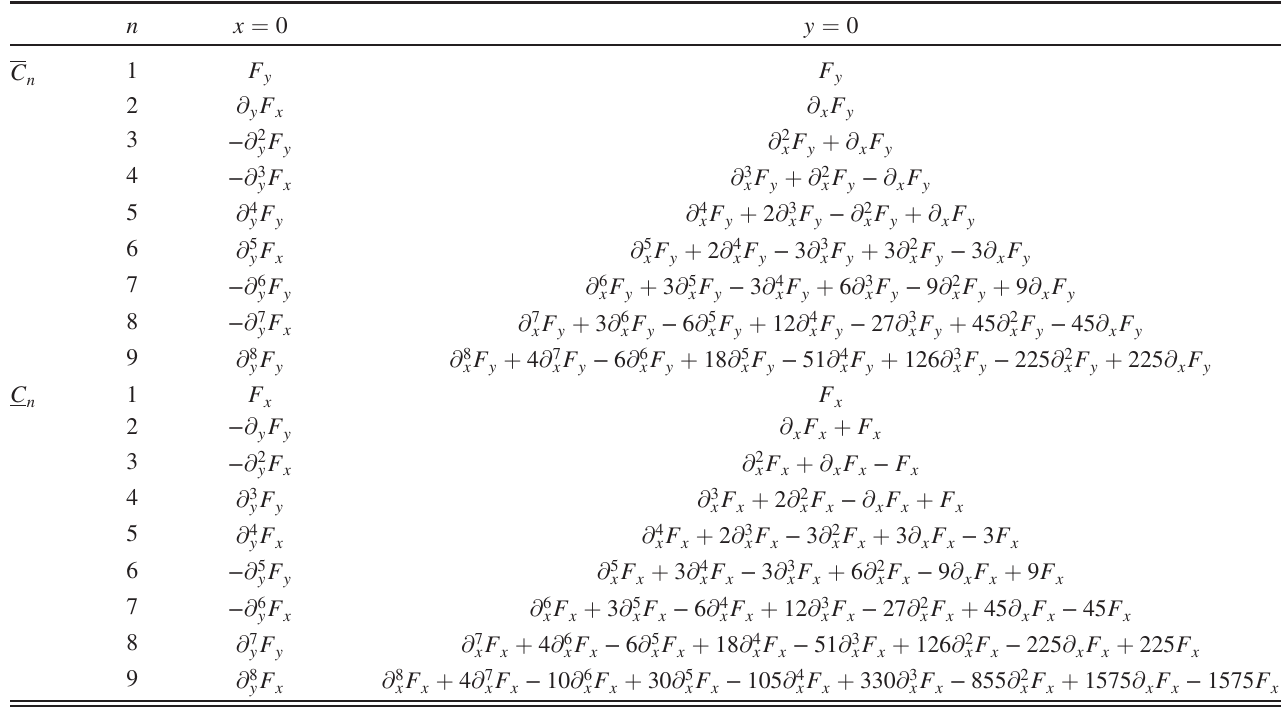
TABLE V. Relationship between coefficients determining the strength of pure normal and skew S-multipoles and power series expansion of field in radial and vertical planes on equilibrium